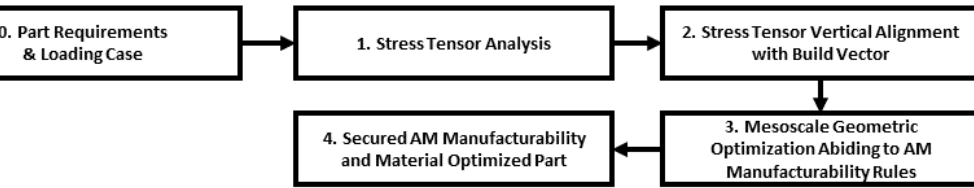
Figure 3. The e ff ect of DfAM rules on production and post-processing workload. Figure 3. The effect of DfAM rules on production and post-processing workload.